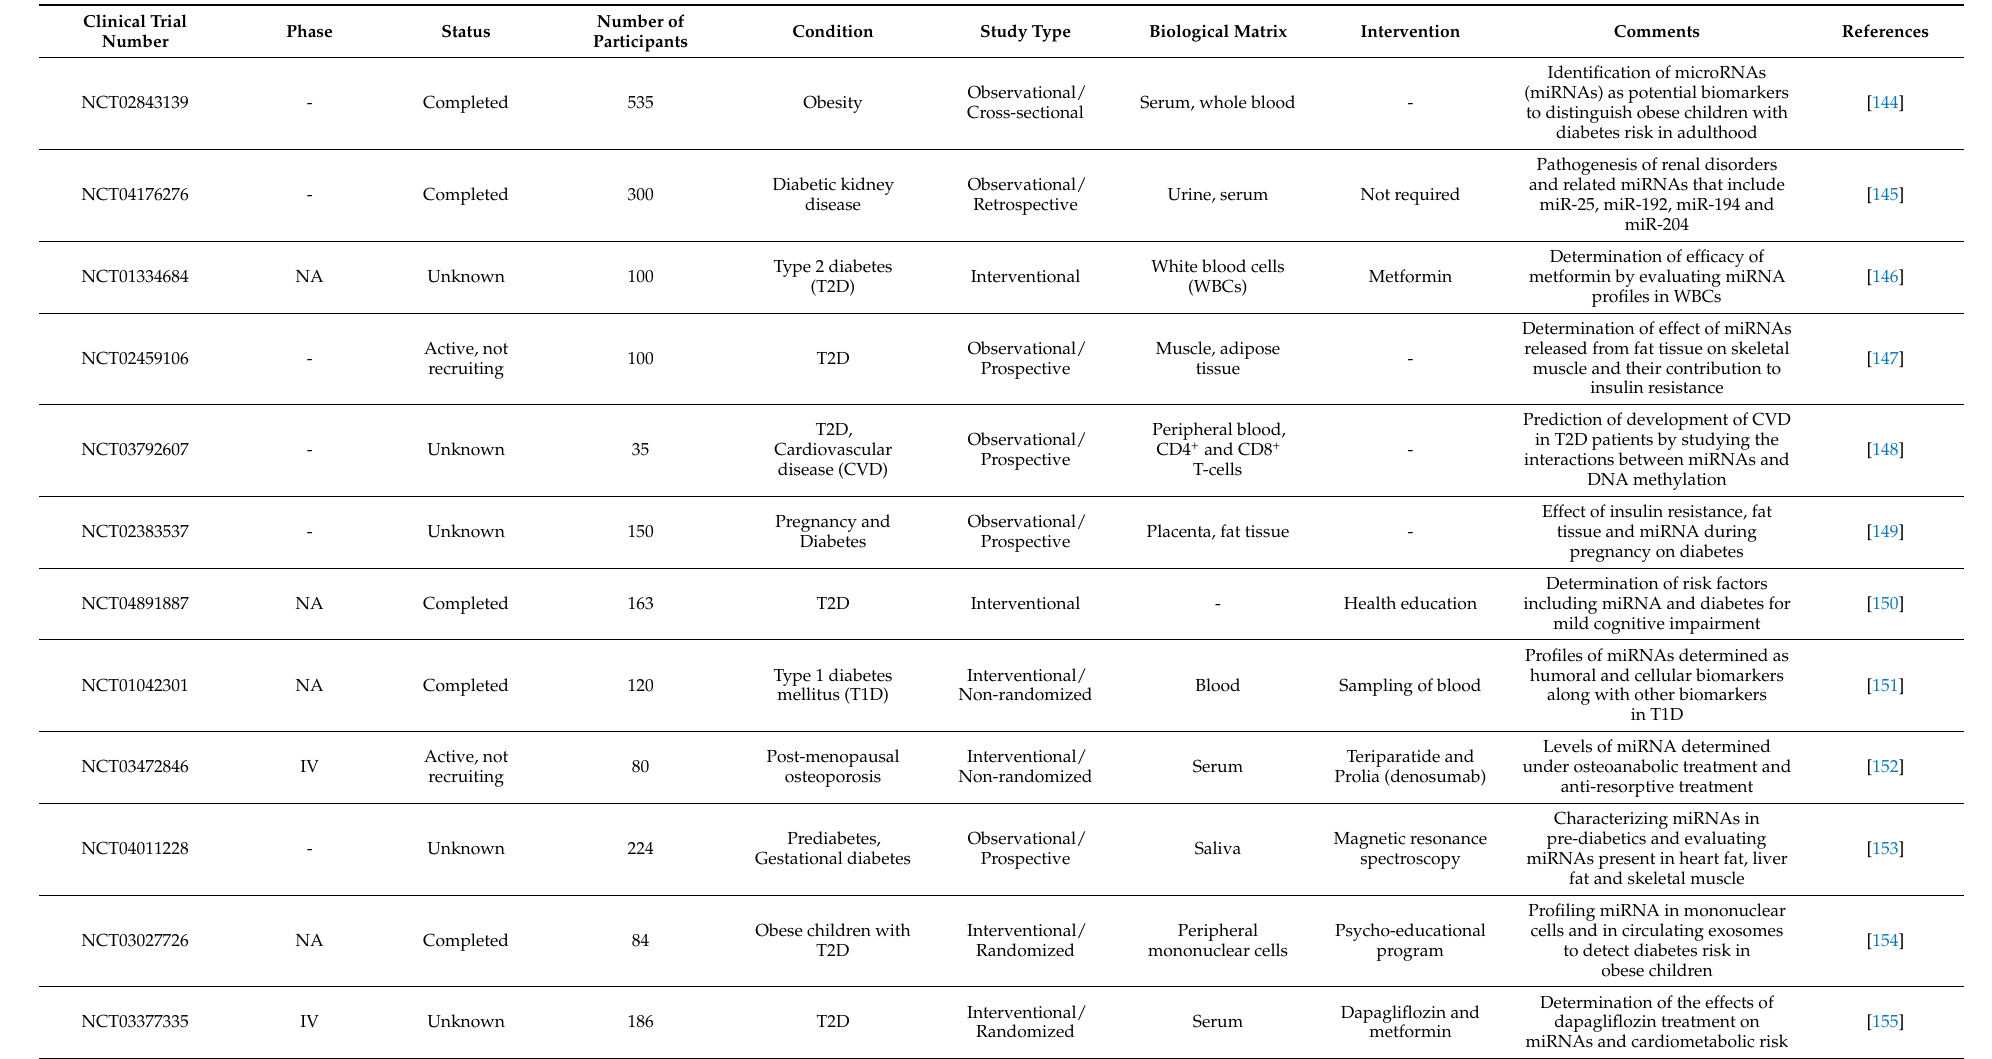
Table 6. Clinical trials on diabetes-associated noncoding RNAs (adapted from www.clinicaltrials.gov; accessed on 31 May